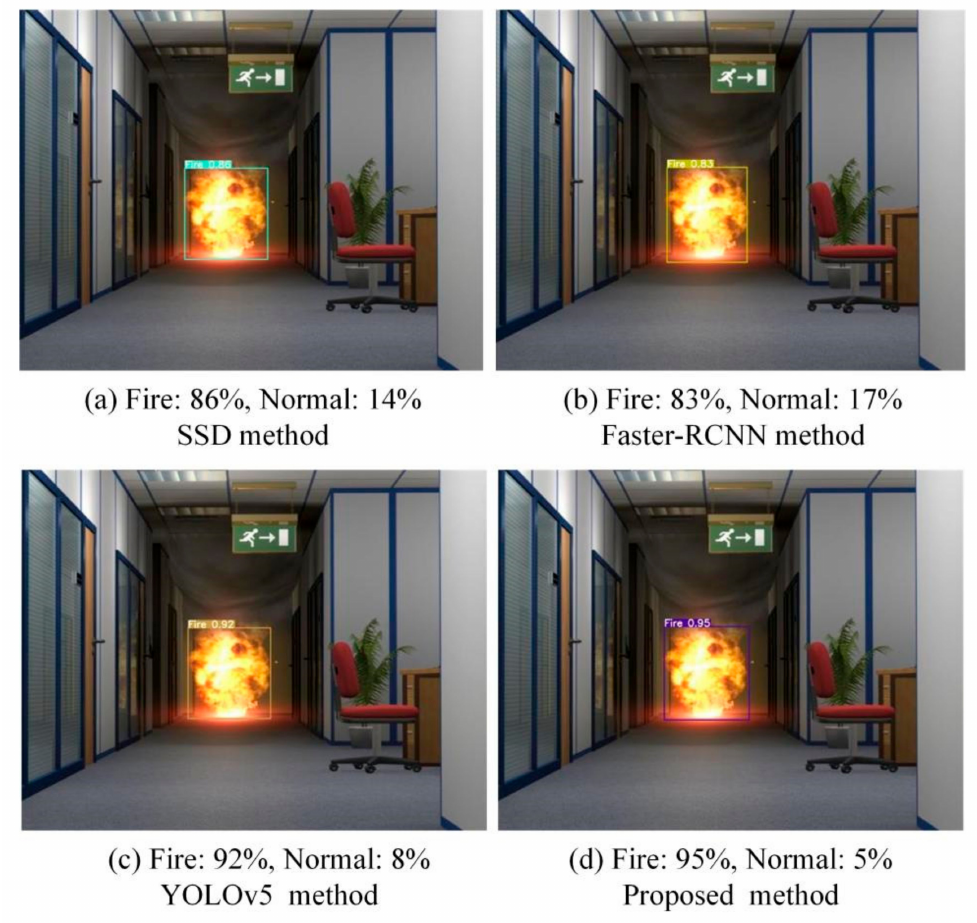
Figure 8. Indoor fire